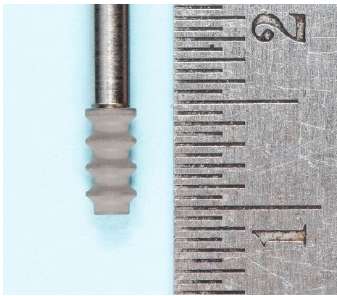
Figure 3. Micro-implant design with outer diameters of 2.5 mm and length 5 mm. the implant is designed with 3 bone chambers and 4 outer rings.